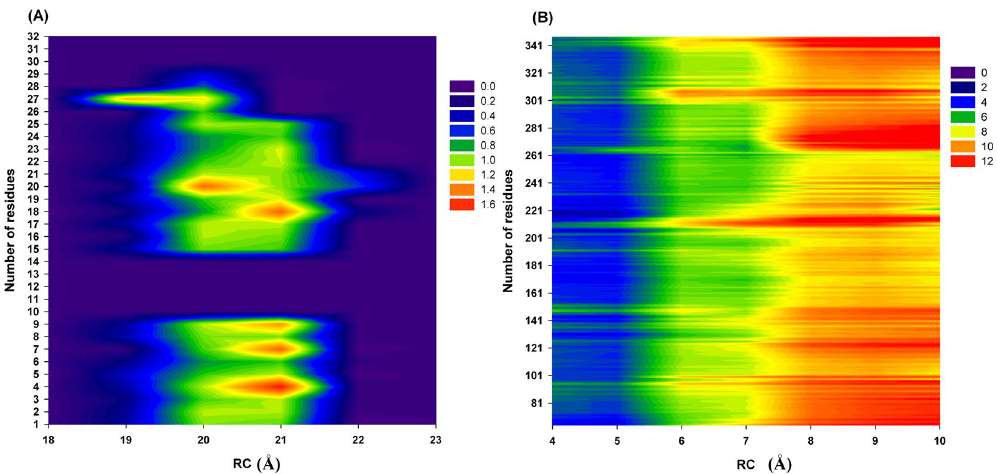
Figure 3. RMSF profiles of an MOR with BU72. ( A ) RC: 18–23 Å; the order of the residues is as follows: Val126, Asn127, Tyr128, Leu129, Met130, Gly131, Thr132, Trp133, Pro134, Cys140, Val143, Ile144, Asp147,